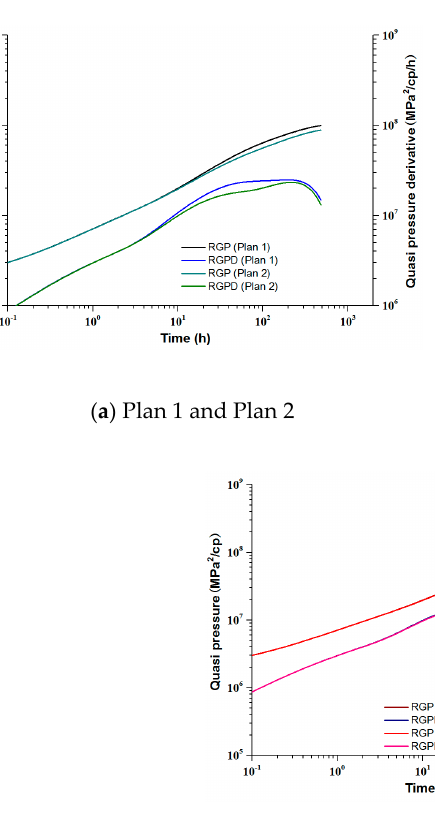
Figure 13. BHP of L2 well with different well pattern and multiple neighboring wells.